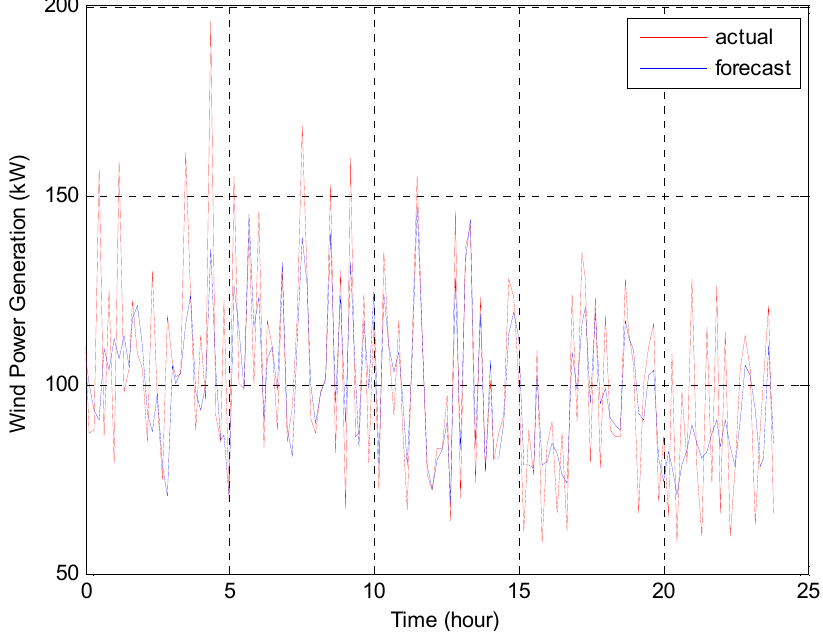
Figure 8. Test results with the proposed hybrid method for typical summer day.